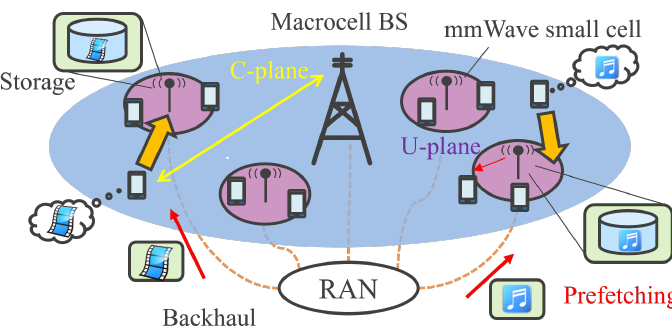
Figure 1. mmWave Edge Cloud system